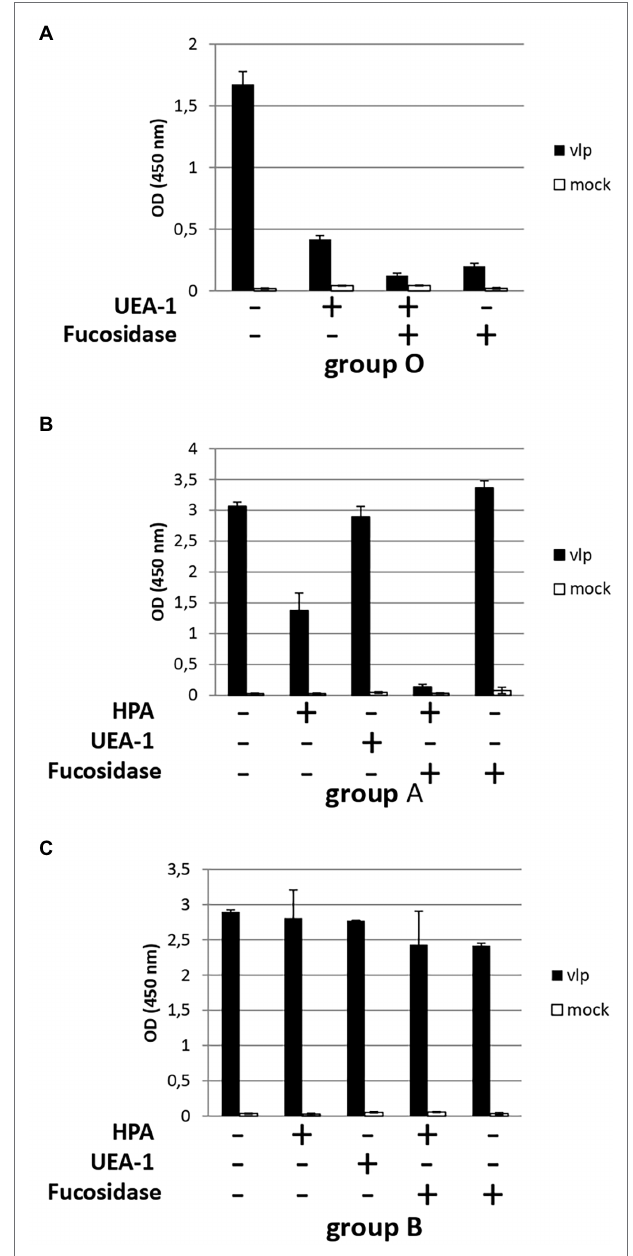
FIGURE 6 | HBGA characterization involved in the recognition of GII.17. Diluted saliva samples from ABO patients were coated on ELISA plate prior to incubation with a combination of lectins (HPA and UEA-I) and 1,2- α -L- fucosidase. For each graph, the presence or absence of lectins and/or fucosidase is indicated below each graph by plus and minus signs, respectively. Blood group saliva is indicated below each graph. (A) For this experiment (with group O saliva) and the following experiments, diluted saliva was first incubated with 1,2- α -L-fucosidase and/or lectin prior to incubation of the coated saliva with VLPs (black bars) or PBS (mock, white bars). (B) Group A saliva. (C) Group B saliva.